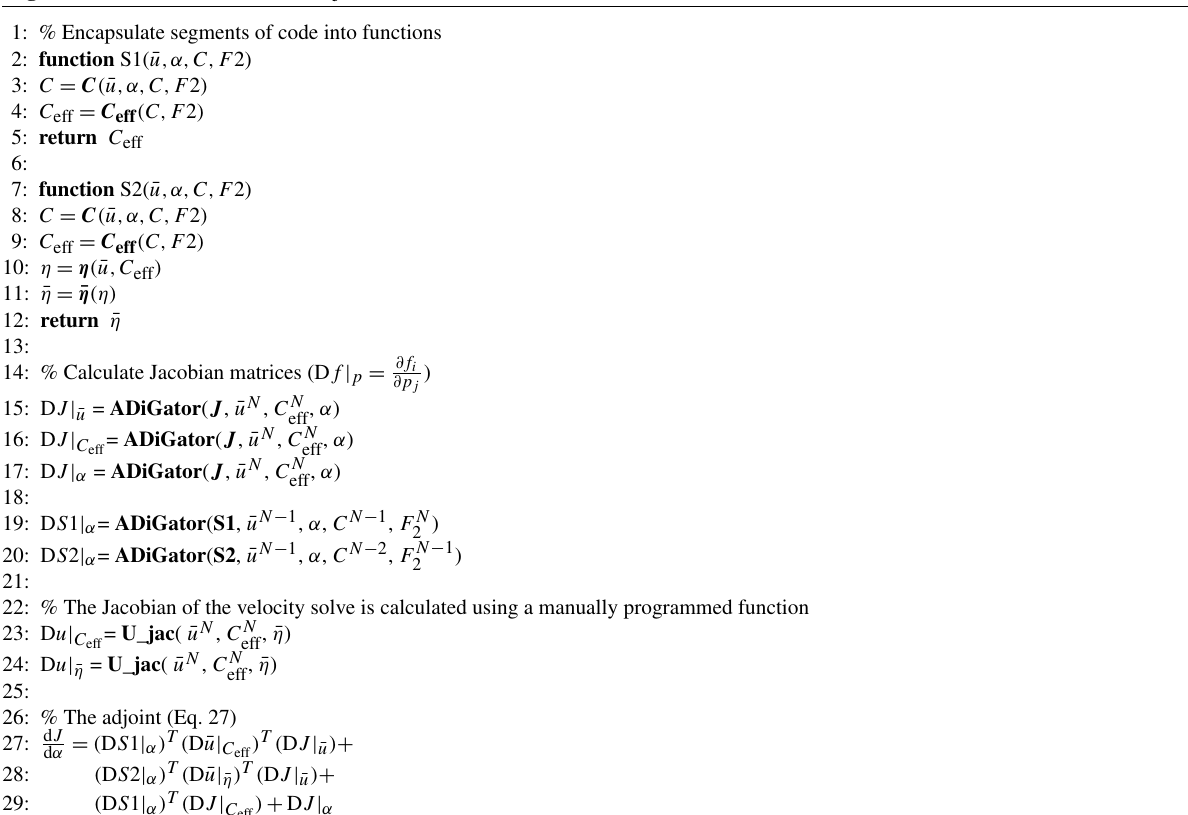
Algorithm 2 Pseudocode of the adjoint